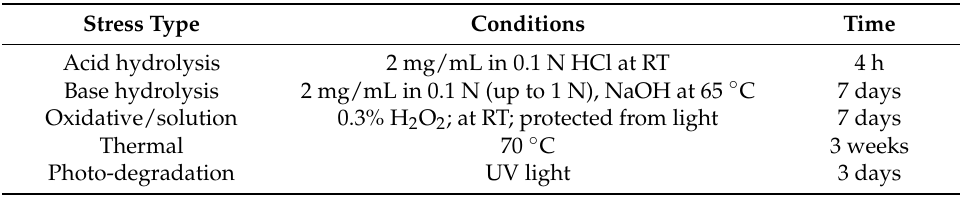
Table 1. Stress conditions applied for drug substance and drug